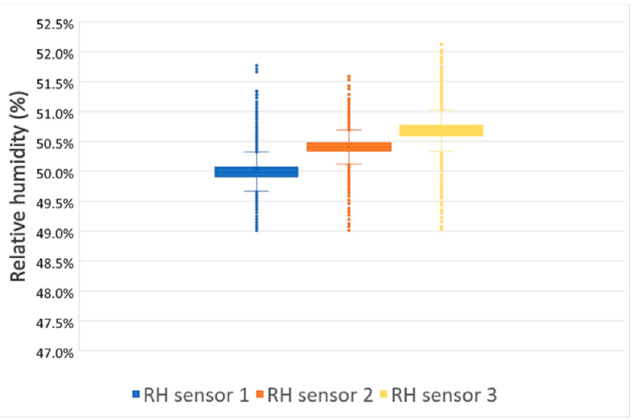
Figure 24. Box and whisker plot of relative humidity observations during test 2.